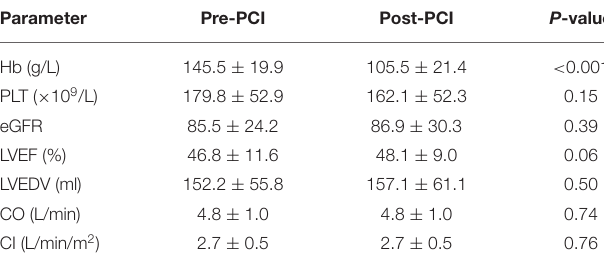
TABLE 2 | Angiographic and procedural characteristics of patients included in this study.